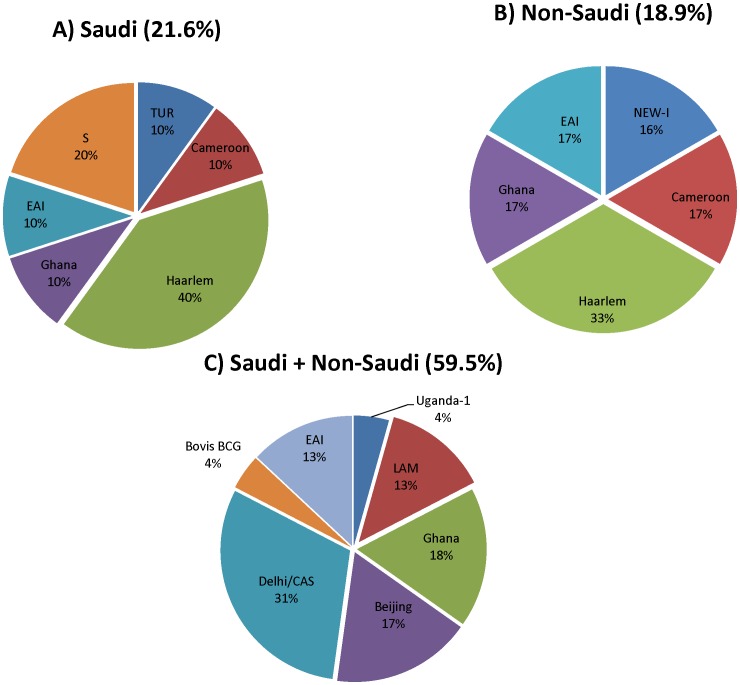
Distribution of strain clusters among the study groups.A) Saudi patients-only, B) non-Saudi patients-only and C) mixed strain molecular clusters. The distribution of strain clusters detected among the three categories is indicated above each diagram. Strain phylogenetic distribution with percentages of different lineages found within each cluster category is also shown. Strain molecular clusters were identified based on isolates sharing identical MIRU-VNTR types and spoligotypes.